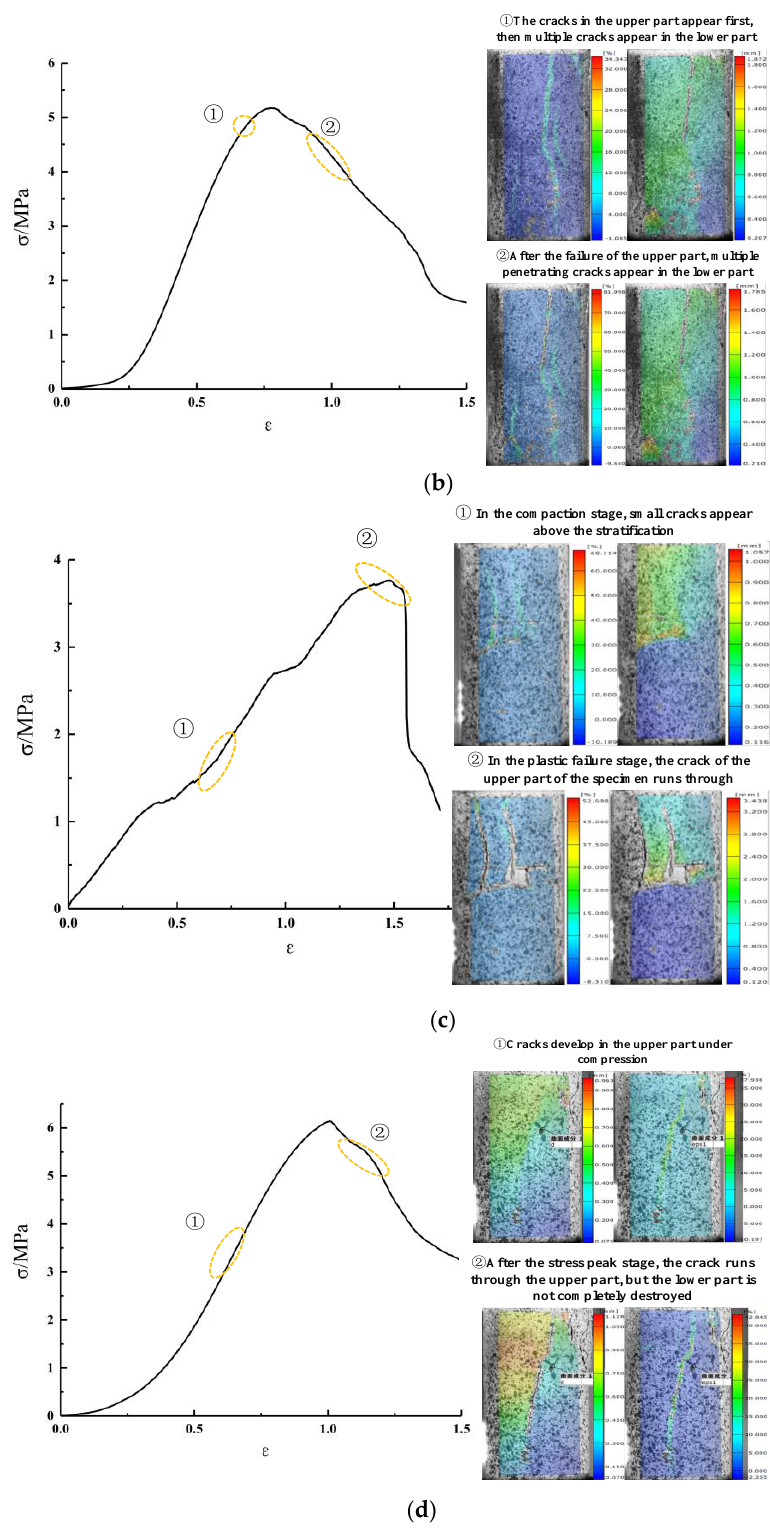
Figure 18. Digital speckle images and stress–strain curves of crack development of ASPLB. ( a ) Digital speckle image and stress–strain curve of crack development in Non-LB. ( b ) Digital speckle image and stress–strain curve of crack development in 1:1 LB. ( c ) Digital speckle image and stress–strain curve of crack development in 1:3 LB. ( d ) Digital speckle image and stress–strain curve of crack development in 3:1